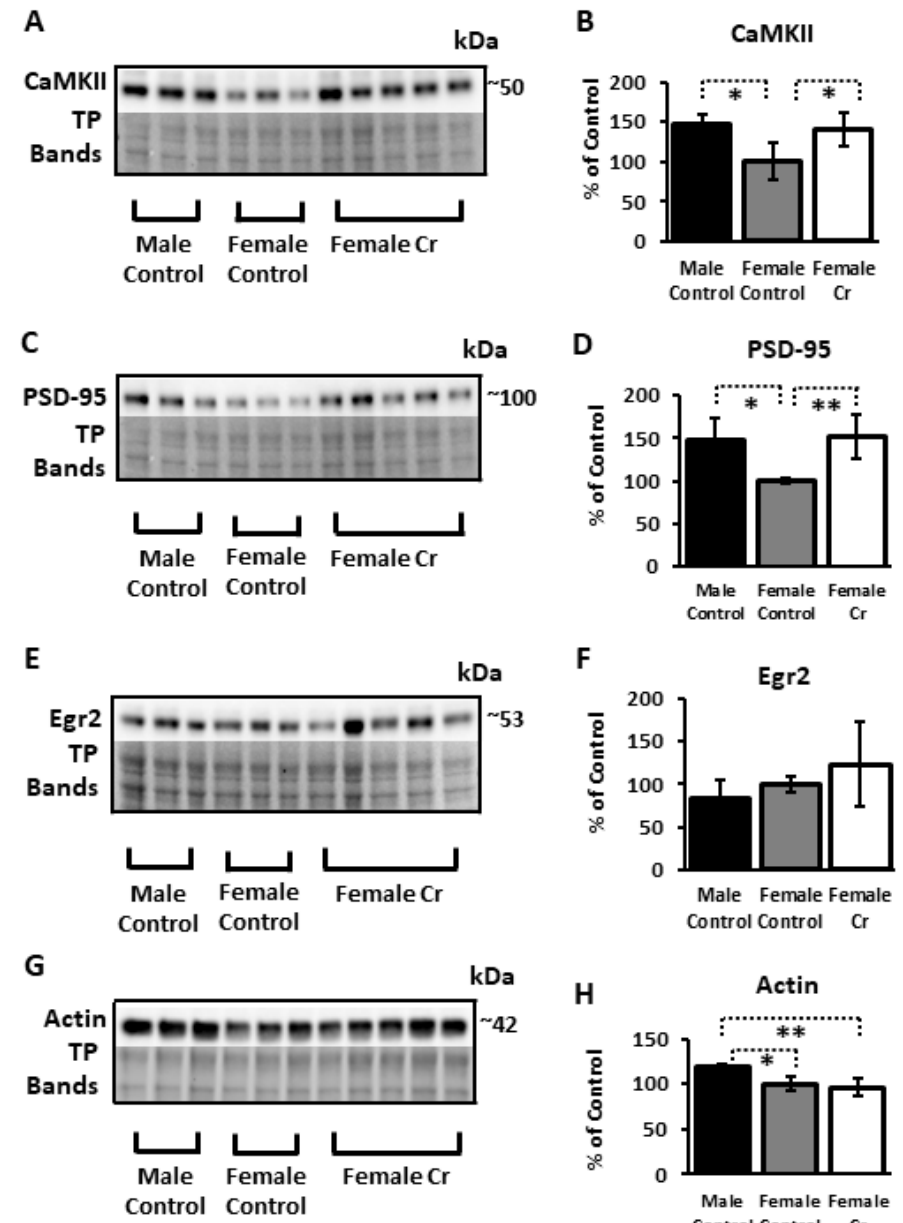
Figure 8. Relative hippocampal levels of nuclear factor kappa b (NF- κ B)-associated plasticity proteins in control and Cr-supplemented 3xTg mice. Representative Western blots depicting protein bands and relative protein levels, respectively, as measured by densitometry after normalizing to total protein (TP; Ponceau S staining or Stain-Free TM for actin) and expressed as the percentage change from female control-fed mice (100% ± SD) of ( A , B ) calcium-calmodulin-dependent protein kinase II (CaMKII), ( C , D ) postsynaptic density protein 95 (PSD-95), ( E , F ) early growth response protein 2 (Egr2), and ( G , H ) actin. ANOVA: n = 3–5; * p < 0.05; ** p < 0.01.